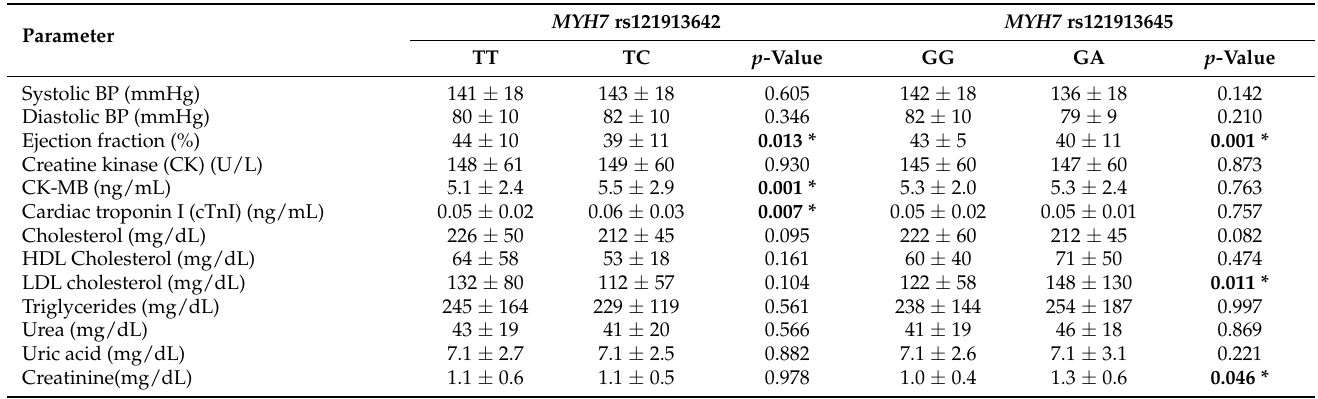
Table 4. Analysis of clinical and biochemical parameters among various genotypes of MYH7 rs121913642 and rs121913645 in cardiac